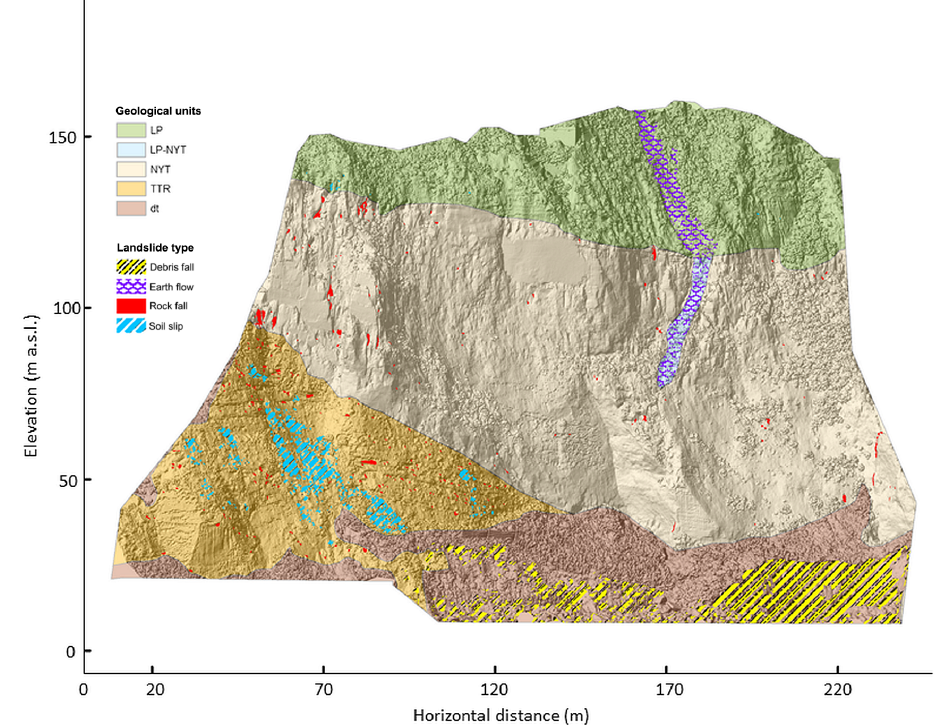
Figure 3. Geological vertical map of the Coroglio cliff (modified after Matano et al., 2016). Landslide types that occurred during the 2013– 2015 interval (Caputo et al., 2018) are also shown. Geological units: LP, stiff to loose recent pyroclastic deposits and soils; LP-NYT, thin layer of LP deposits on NYT unit; NYT, Neapolitan Yellow Tuff; TTR, Trentaremi Tuff; dt, slope talus breccia and gravelly beach